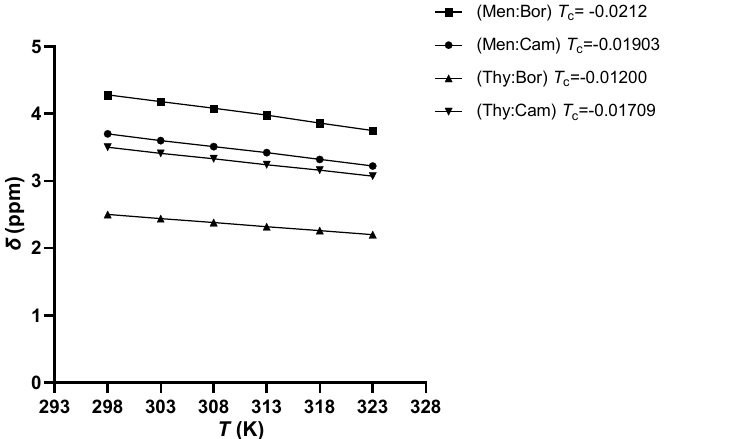
Figure 3. Plot of the chemical shifts ( δ ) of the OH proton as a function of temperature for each eutectic system.